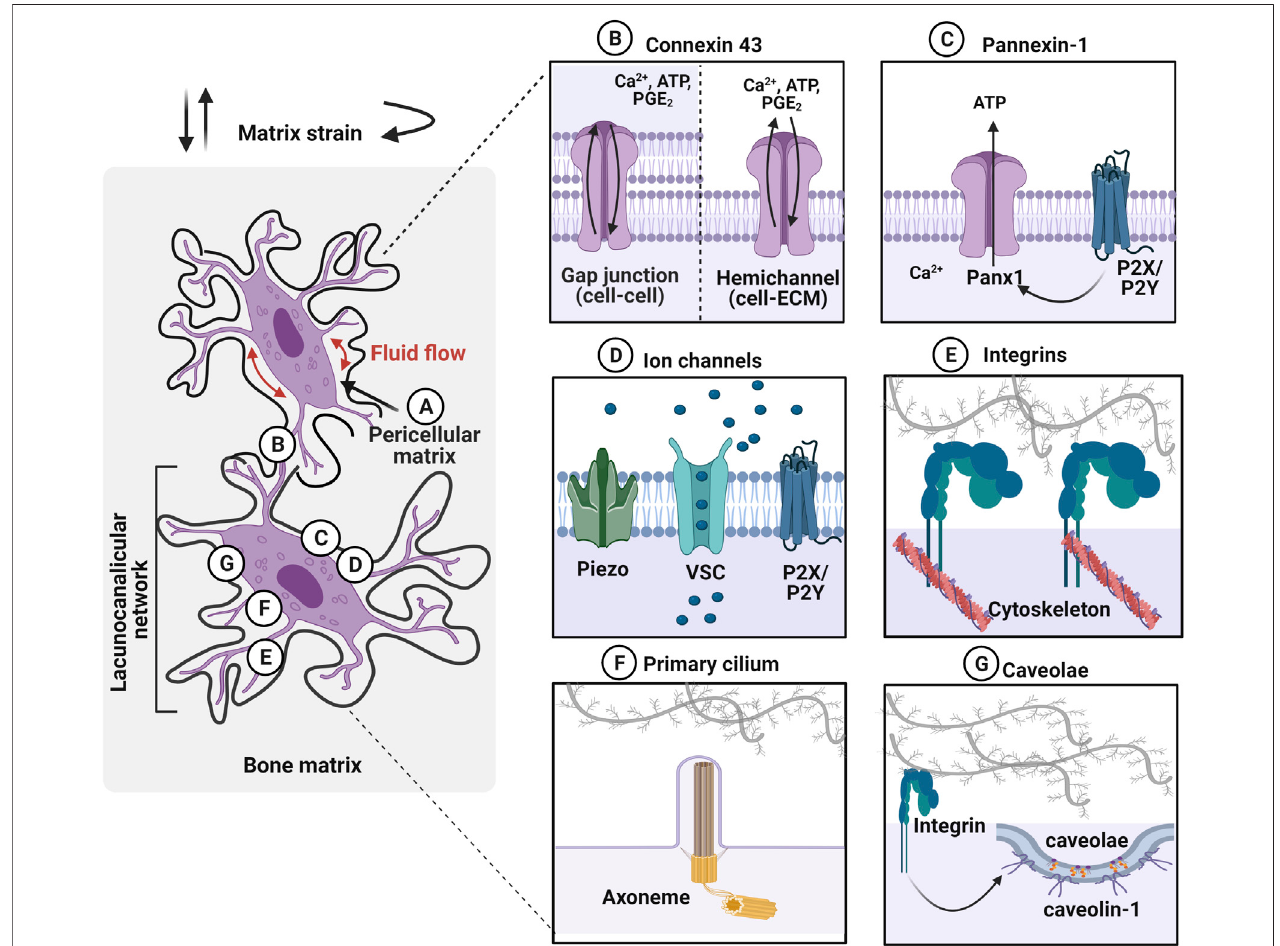
FIGURE 2 | Osteocytes within the lacunocanalicular network express mechanosensors, which can be activated by various mechanical stimuli such as fl uid fl ow in the pericellular matrix and matrix strain (e.g., compressive, tensile, and torsional loading). (A) Osteocytes are surrounded by the pericellular matrix, between the cell and the walls of lacunae and canaliculi, which acts as a tether for osteocytes to transduce the mechanical stimulation. (B) Gap junctions, expressing on dendritic cell processes, facilitate cell – cell communication between osteocytes. Especially, connexin 43 (Cx43) is highly expressed and these junctions can also function as hemichannels that open to the microenvironment. Mechanical stimuli open these channels and transport calcium ions (Ca 2+ ), adenosine triphosphate (ATP), and prostaglandin E2